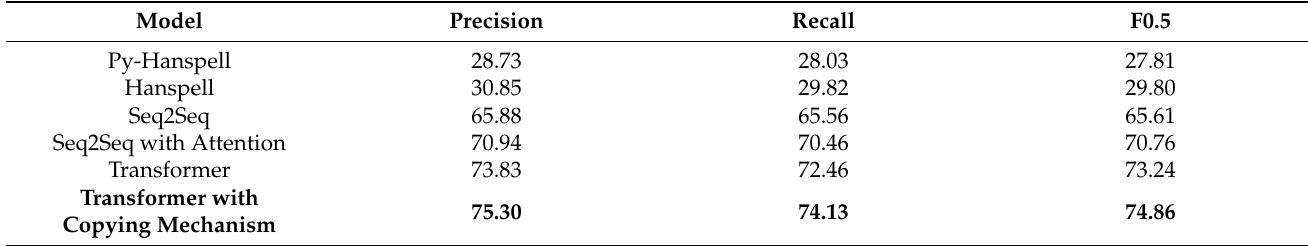
Table 10. Comparison of GEC Models (Precision, Recall,